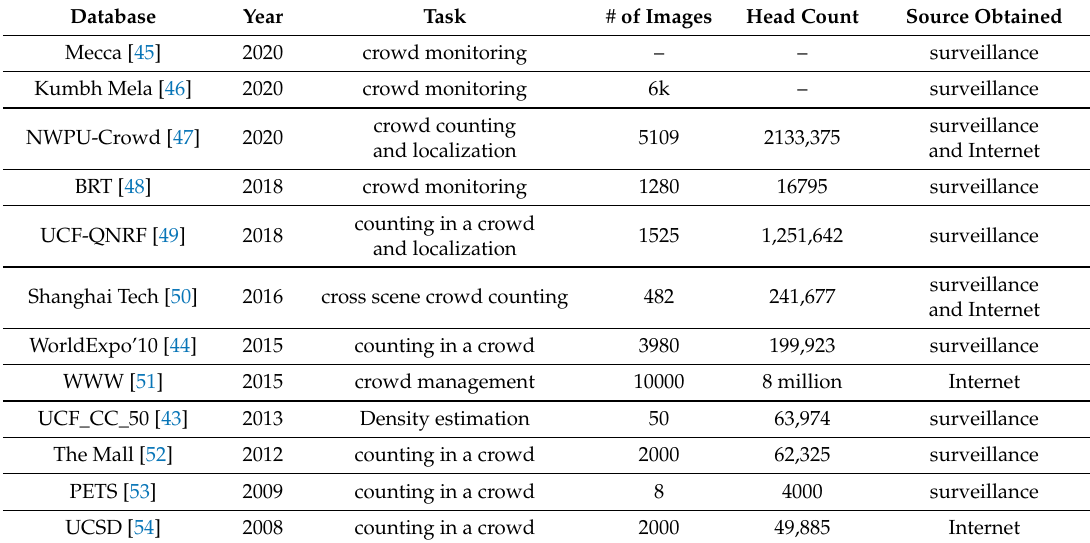
Table 1. Major Crowd Monitoring System (CMS)